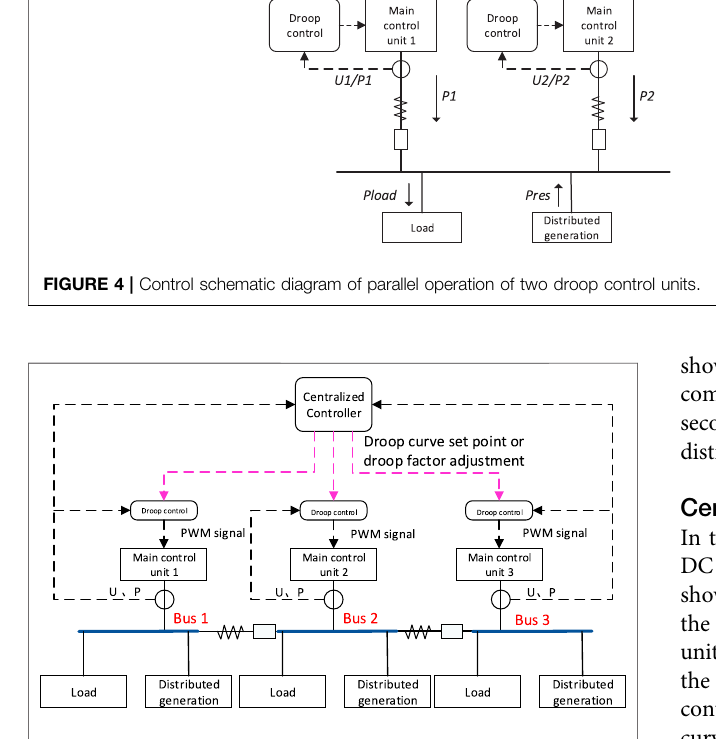
FIGURE 5 | Schematic diagram of secondary centralized control